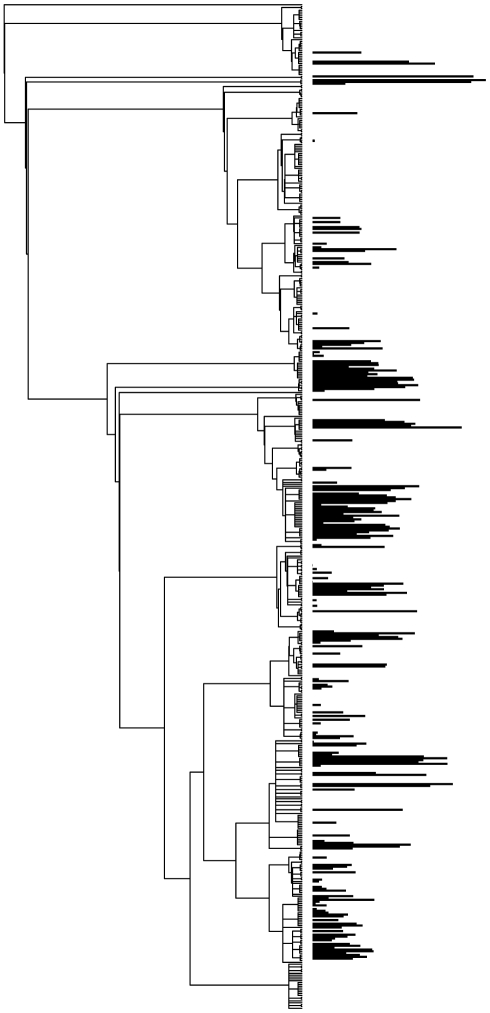
Phylogeny of all species in the community samples.Mean tooth-area character mapped at tips of the phylogeny of all species in the community samples [12] to illustrate non-random variation across the phylogeny of both presence of teeth and tooth area.